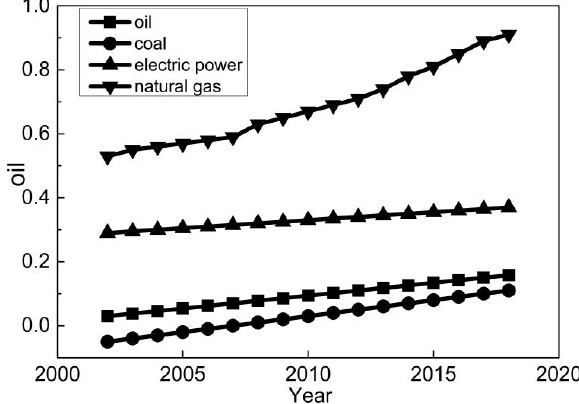
Fig. 5 Output elasticity of different energy